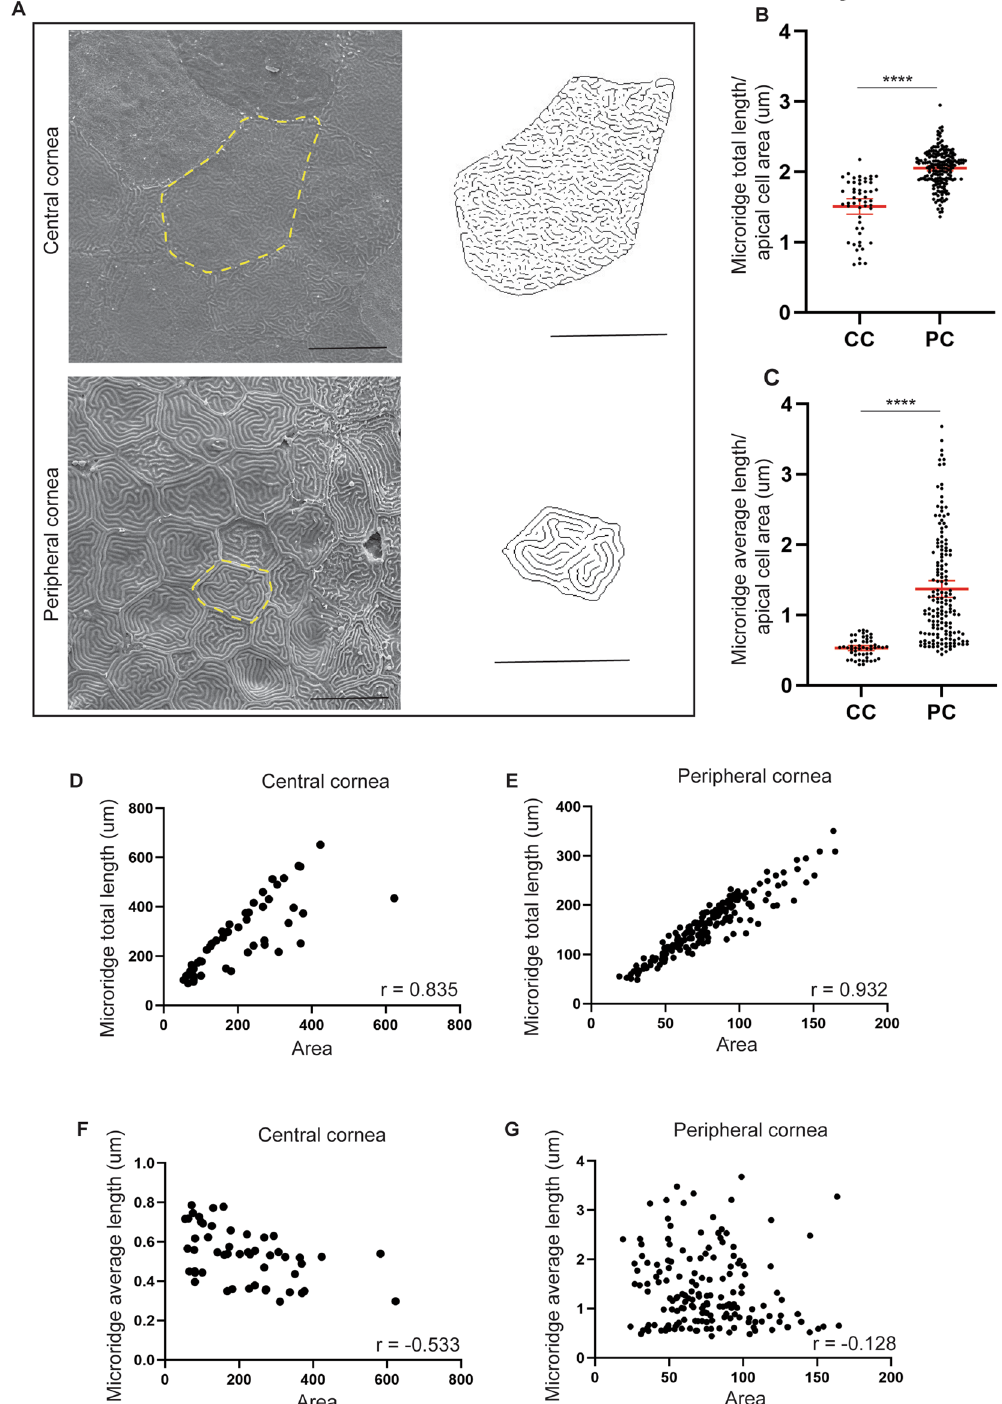
Figure 6. Measures of microridges on zebrafish cornea. ( A ) Representative SEM images on central and peripheral cornea on the left. On the right, the digitally treated images used to measure the parameters of microridges. ( B , C ) Average microridge amount ( B ), and length ( C ), per apical cell area on central and peripheral cornea (n = 52 for CC in ( B , C ), n = 192 for PC in ( B ), and n = 162 for PC in ( C ) after removal of outliers). These parameters are systematically higher in peripheral cornea compared to central cornea. Data represent mean + 95% confidence interval, P **** < 0.0001, Man-Whitney test, two-tailed, with exact p value. ( D – G ). Correlation of microridge amount or average microridge length, and apical cell area, on central and peripheral cornea (n = 50 in D, 51 in E, 192 in F, and 162 in G, after removal of outliers). While the total length displays a correlation with cell apical area, the average length of microridges offers no correlation with cell apical area. Spearman correlation, two-tailed, with approximate p value, P **** < 0.0001. Cells from 3 eyes were pooled for every analyses. Scale bars: 10